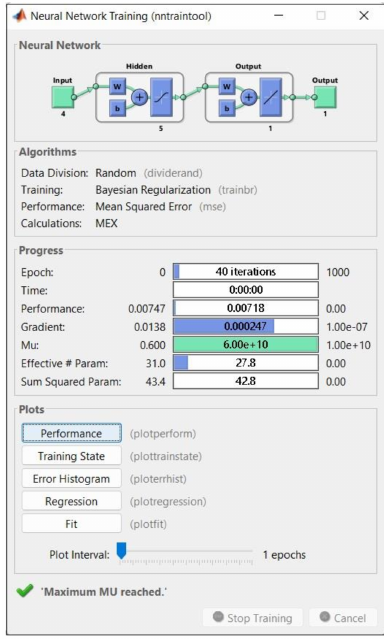
Figure 7. The training tool in MATLAB.